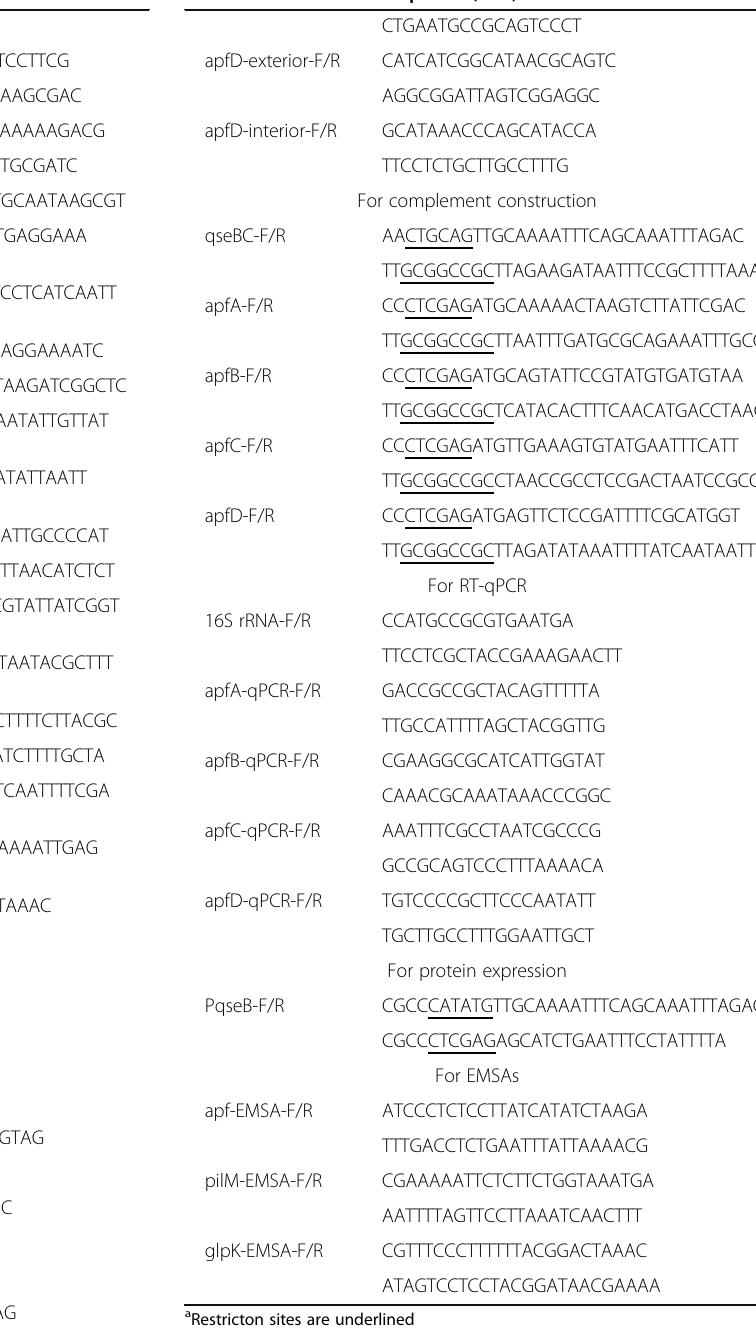
Table 2 Primers used in this study